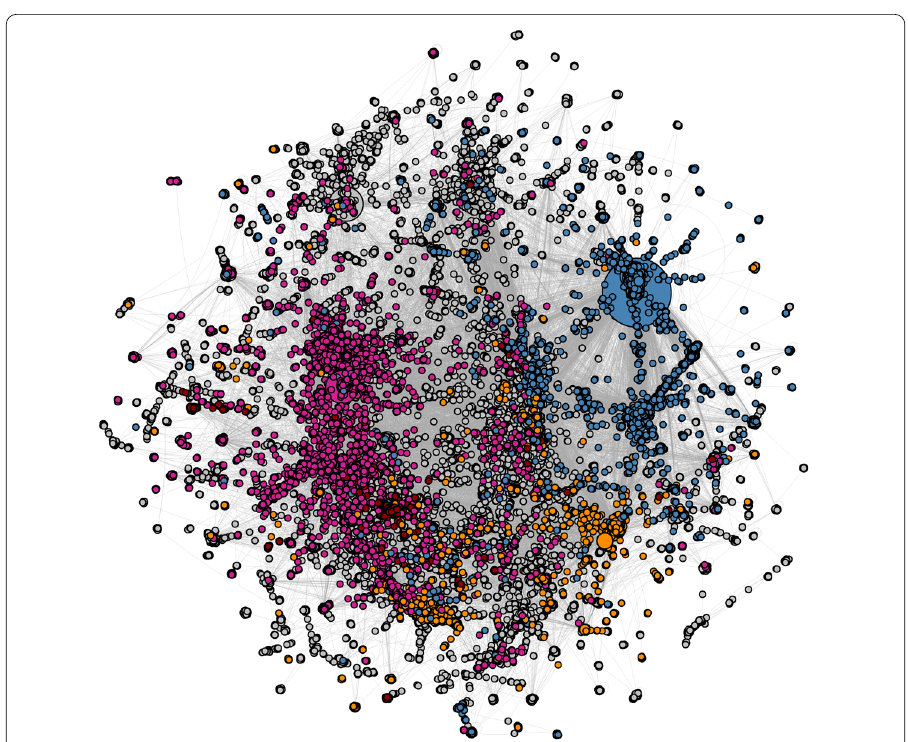
Figure 3 The directed validated projection of the retweet activity network: the communities have been highlighted according to the political discursive groups they take part to. All nodes not belonging to political discursive communities are in grey. Nodes’ dimensions are proportional to their out degree. The layout used for network visualization is the Distributed Recursive (Graph) Layout